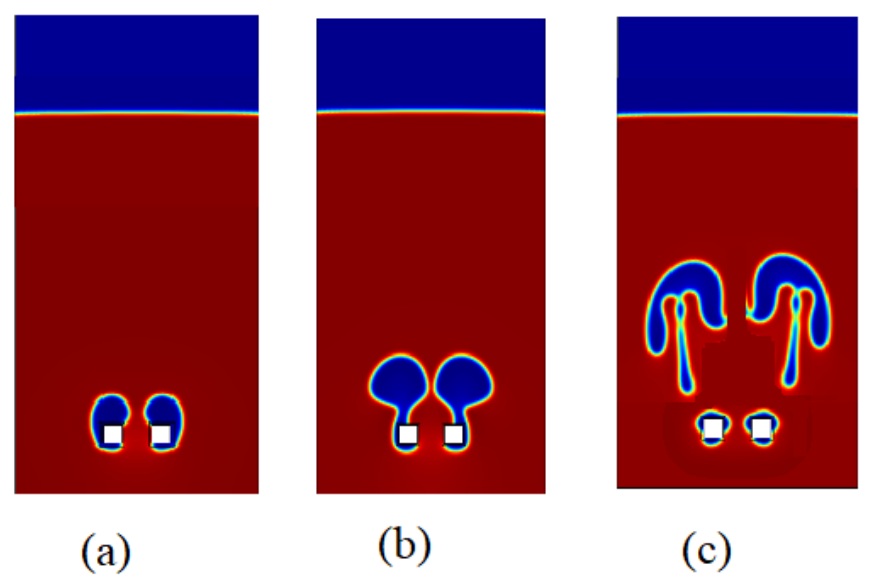
Figure 14. Bubble growth in horizontal